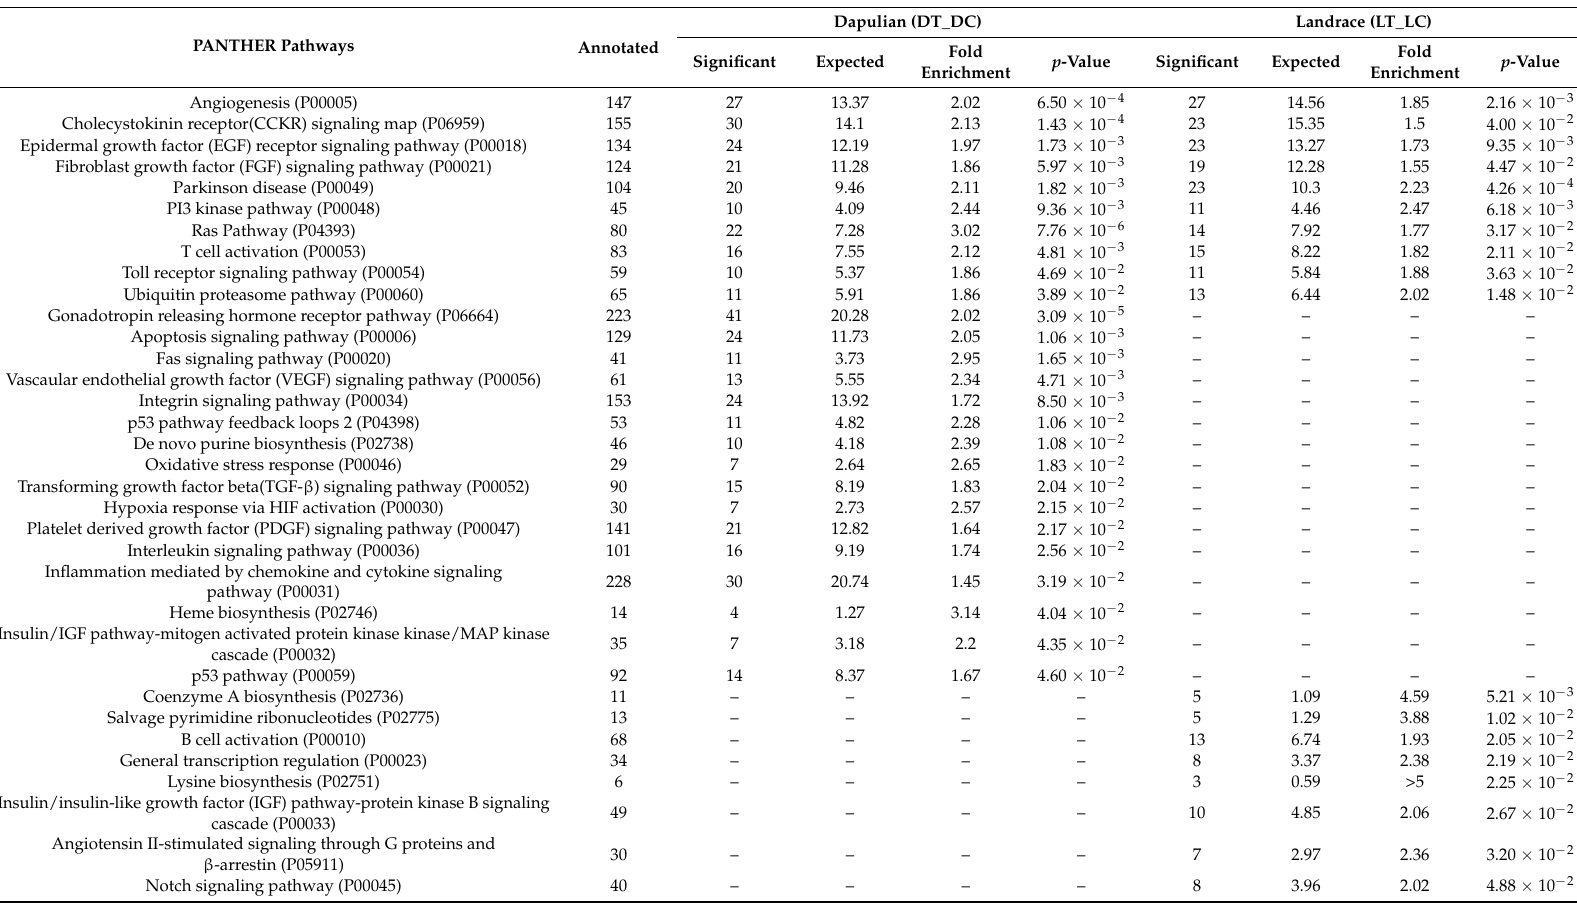
Table 1. Significant PANTHER pathways for target genes for the differentially expressed (DE) miRNAs between the poly I:C stimulation group and control group of Dapulian (DT_DC) and Landrace